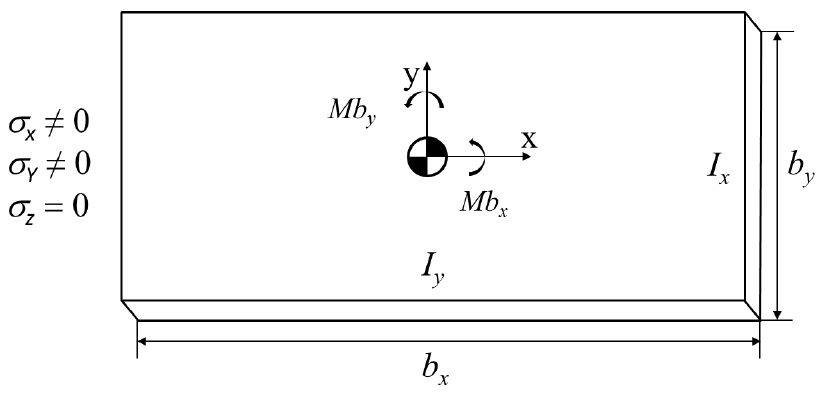
Figure 1. Hypothesis for bulk or blank-initial residual stresses (BIRS) characterization by the on-machine layer removal method.